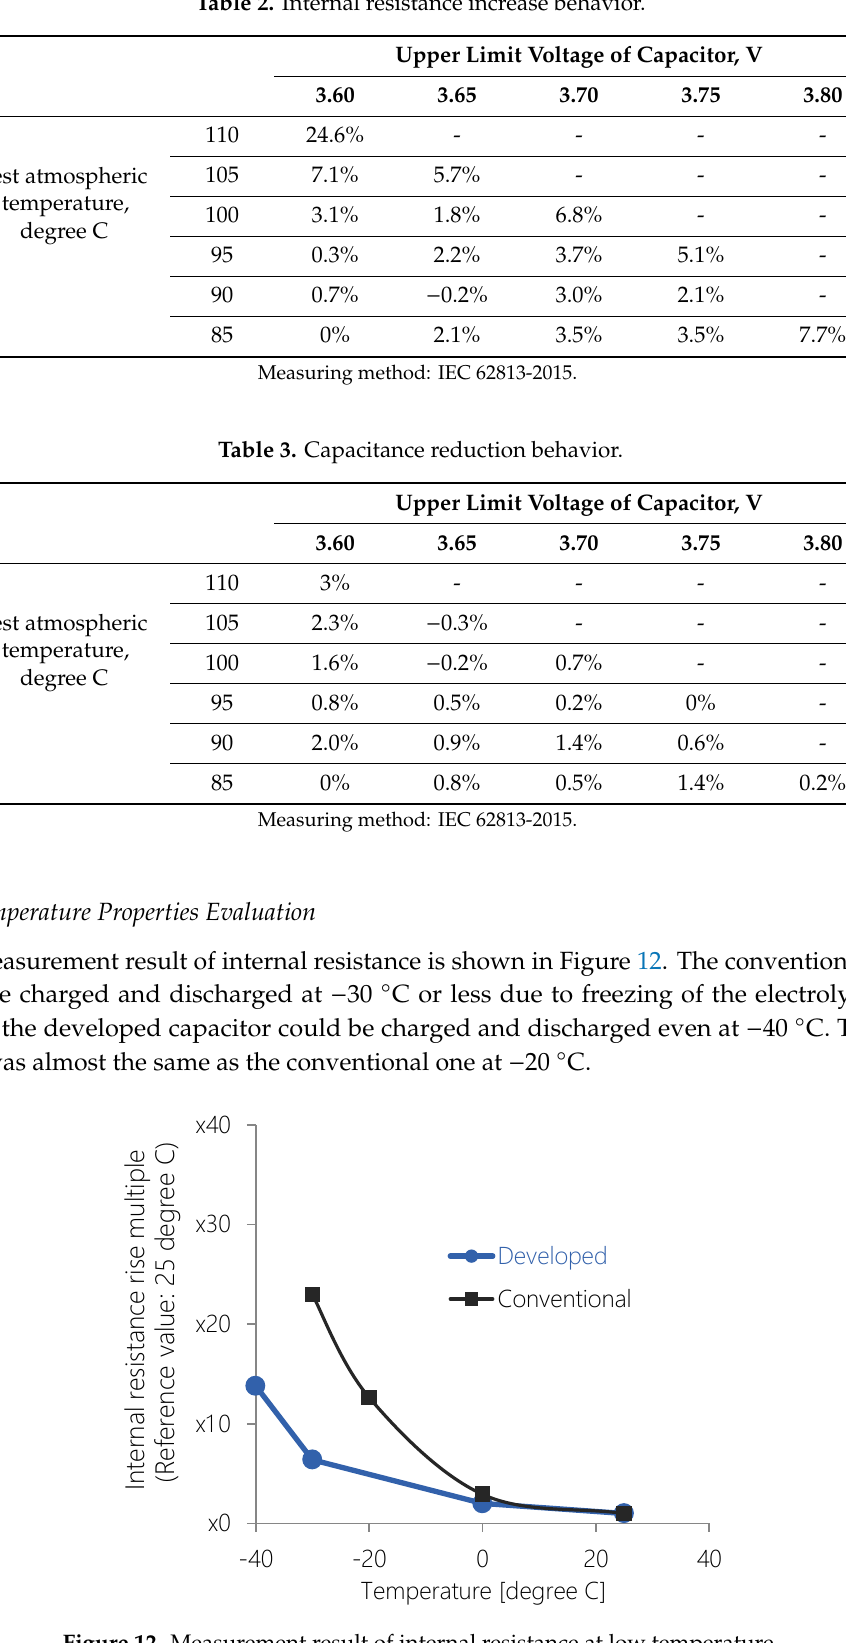
Figure 12. Measurement result of internal resistance at low temperature.